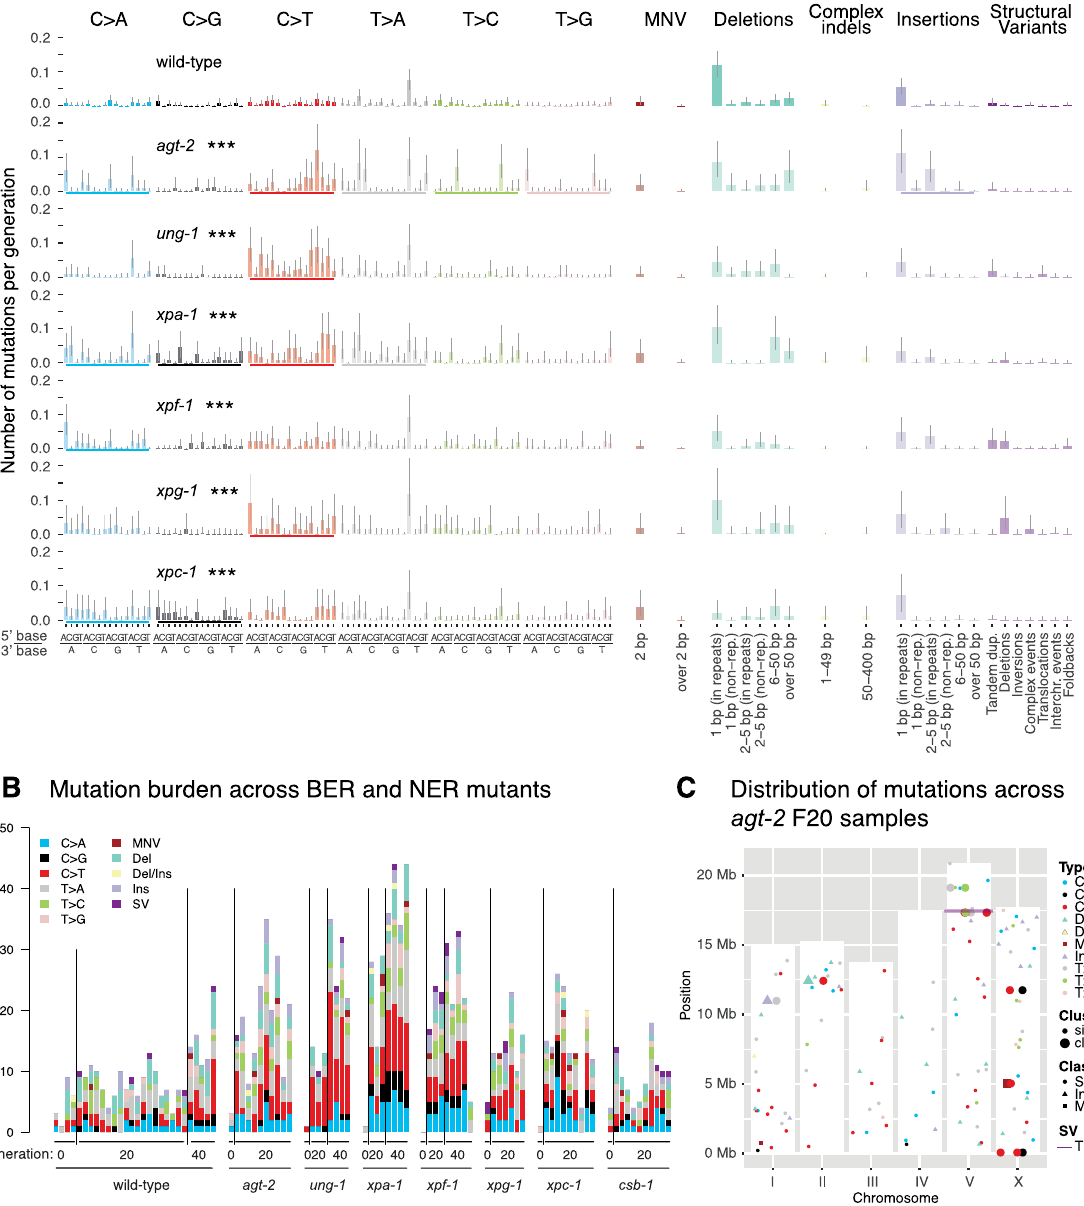
PLOS ONE | https://doi.org/10.1371/journal.pone.0250291 April 27, 2021 7 /